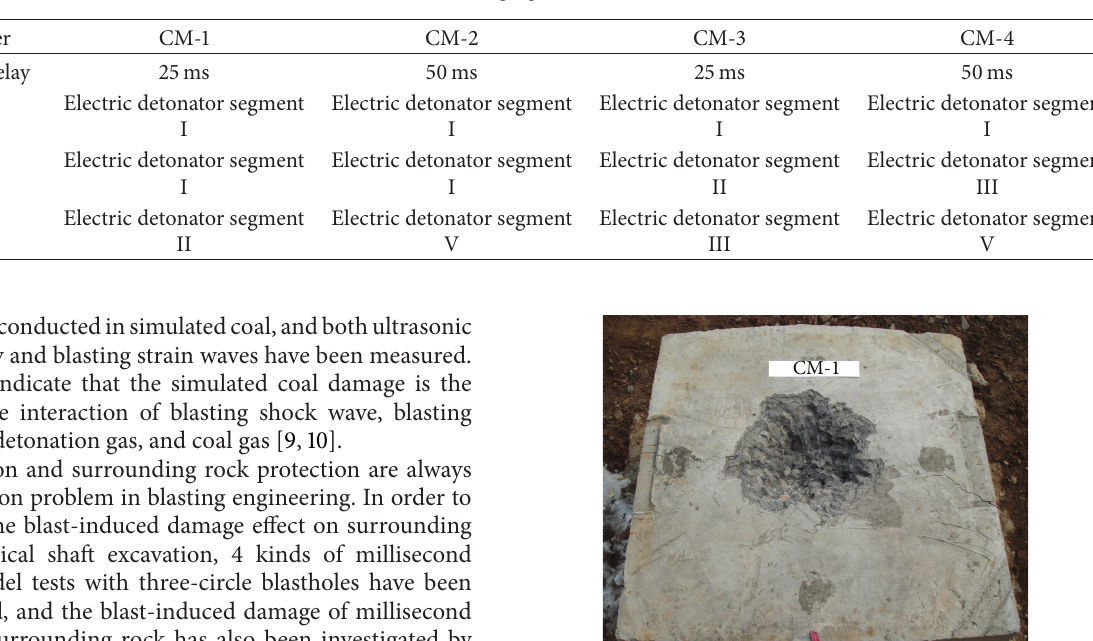
Table 1: Charging scheme.